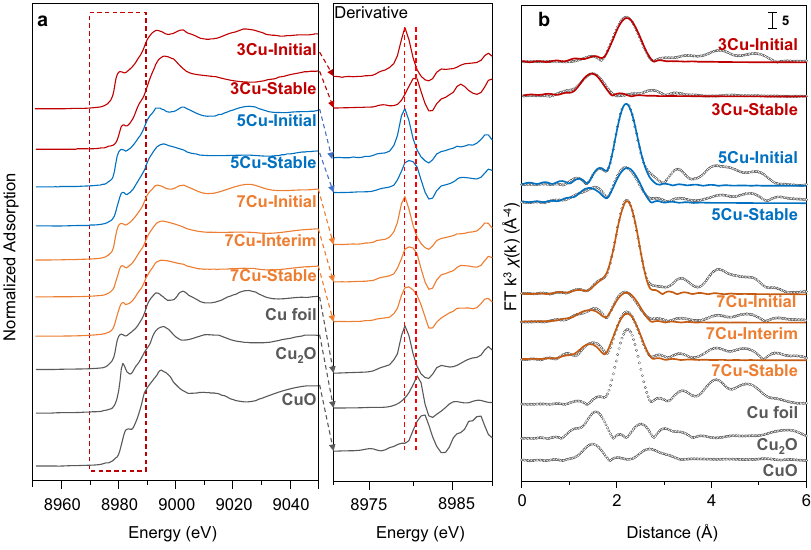
Fig. 2 | XAFS characterization of Cu species during atomic thermal diffusion process. a Cu K XANES spectra and the fi rst derivatives of catalysts with different Cu loadings and stages, while the Cu K adsorption energies are listed in Table 1. b Cu R space EXAFS spectra of catalysts with different Cu loadings and treatment